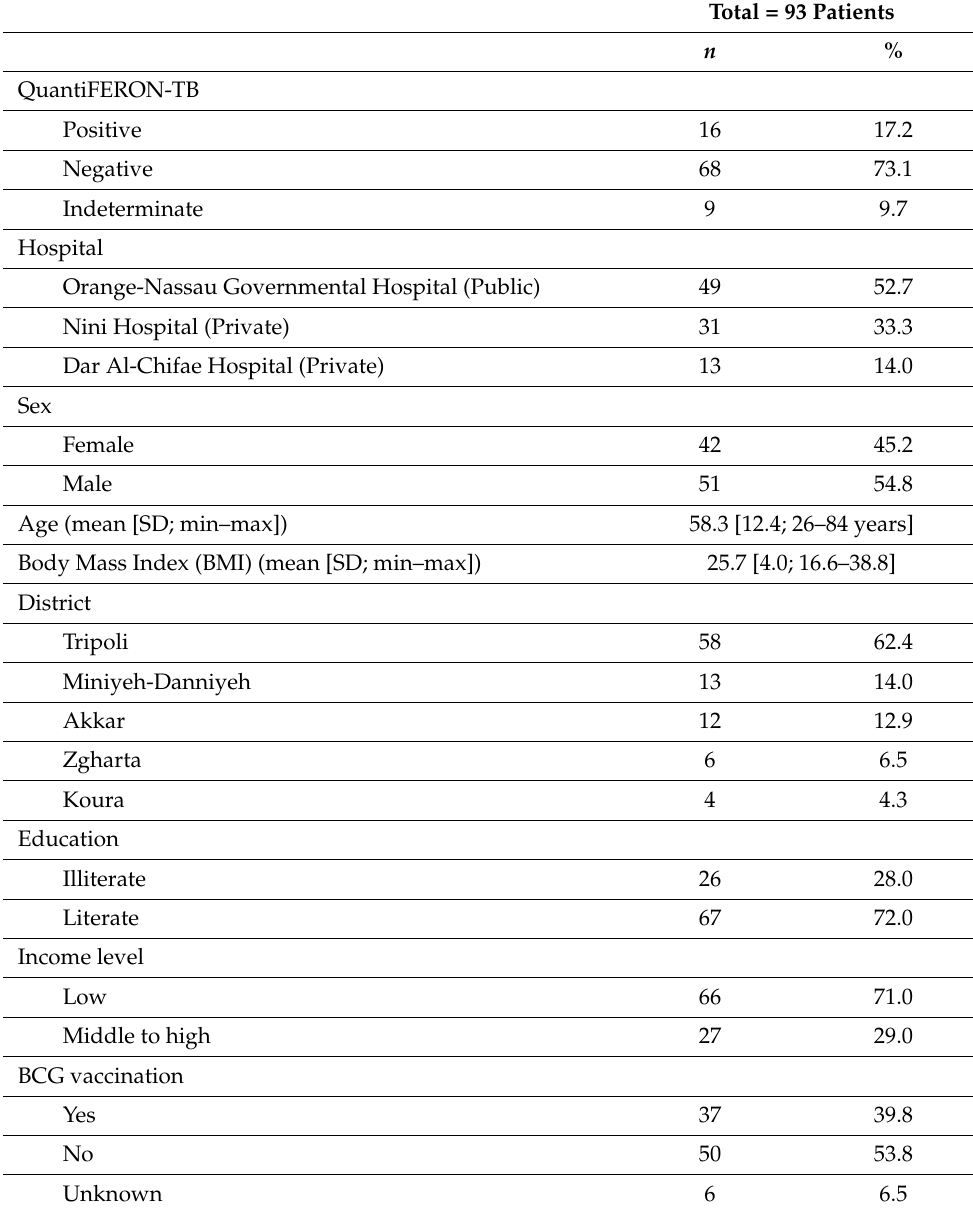
Table 1. Sociodemographic and clinical characteristics of the study population and the prevalence of latent tuberculosis infection.